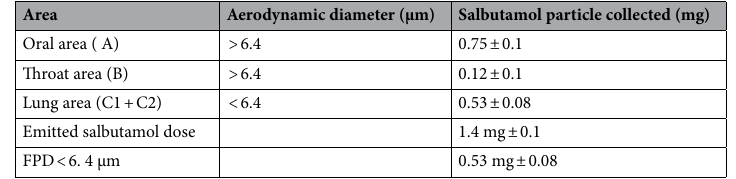
Table 2. The deposition of salbutamol in each area measured by the two-stage impinger model.